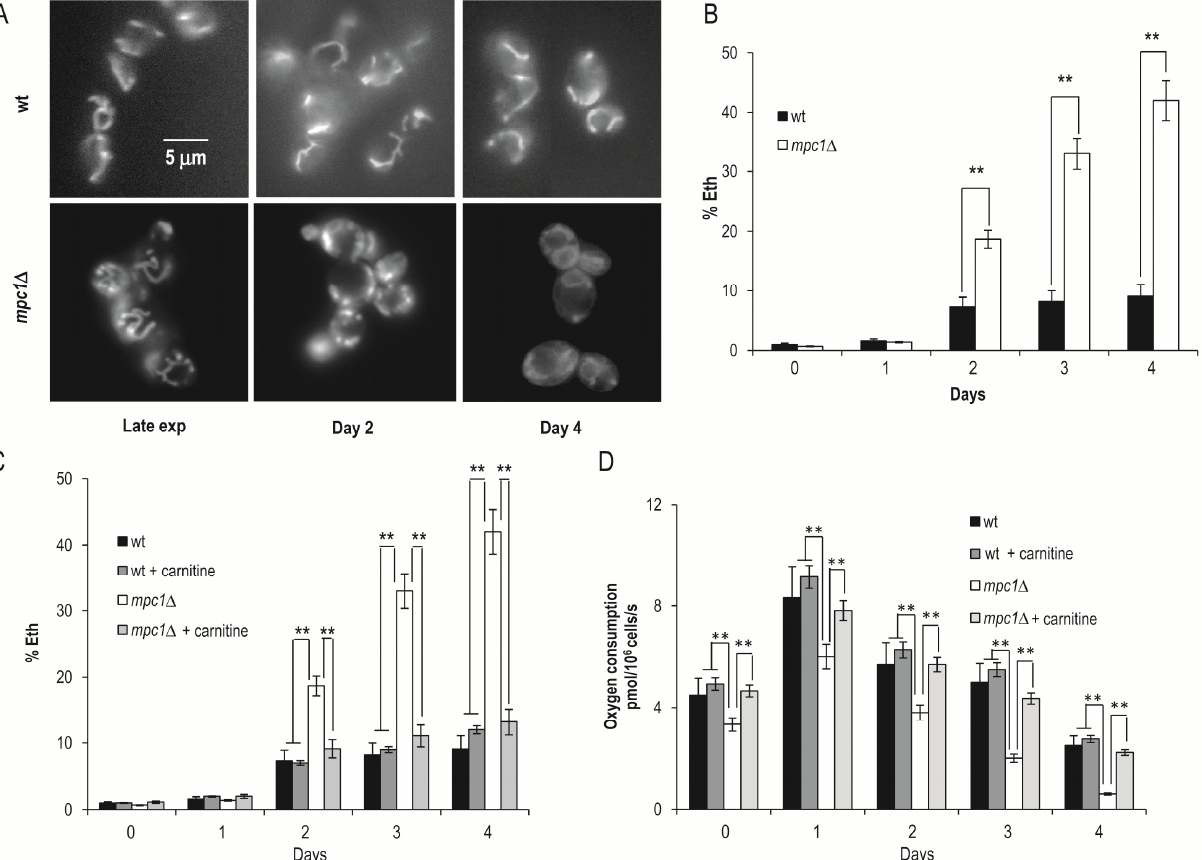
FIGURE 6: Chronologically aging mpc1 ∆ cells display damaged mitochondria. (A) Representative images of wt and mpc1 Δ cultures of Figure 2 stained with DiOC 6 to visualize mitochondrial membranes. Morphologies of the mitochondria in late exponential phase (Late exp) are also shown. The same cultures were assessed for the presence of intracellular superoxide by conversion of non-fluorescent dihydroethidium into fluorescent ethidium (Eth). Summary graphs of the percentage of fluorescent/superoxide positive cells (% Eth) are reported (B). (C) Summary graphs of % Eth cells and (D) cellular respiration determined in wt and mpc1 Δ cultures grown in minimal medium/2% glucose supplemented with carnitine (10 mg/L). Day 0, diauxic shift. For the determination of Eth cells, evaluation of about 1000 cells for each sample (three tech- nical replicates) in three independent experiments was performed. SD is indicated. * P ≤ 0.05 and ** P ≤